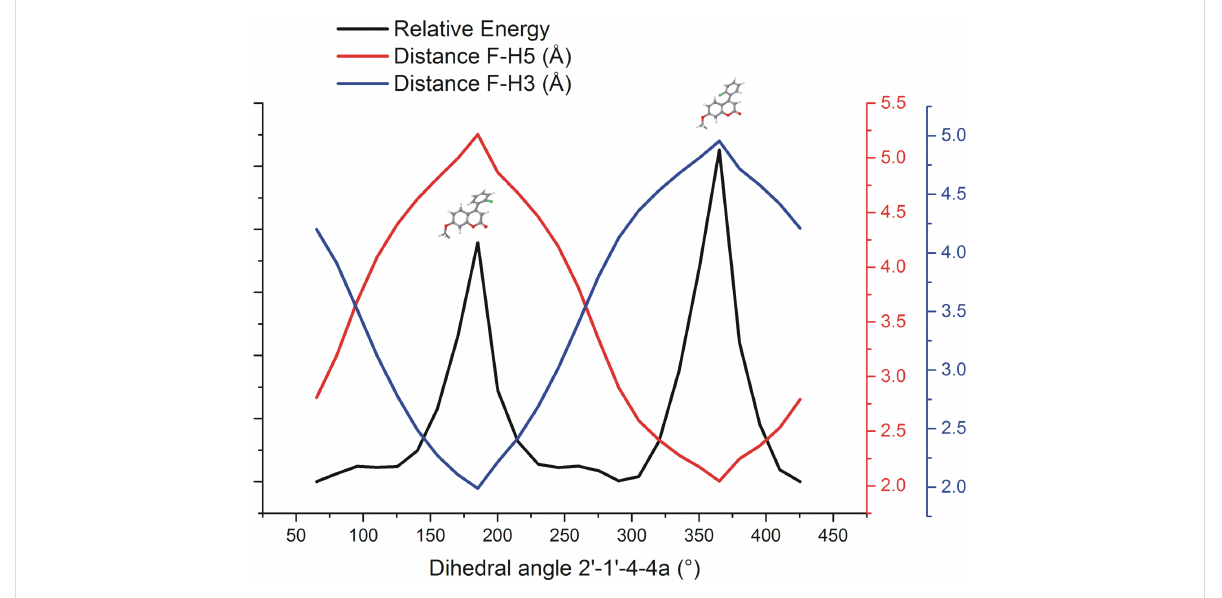
Figure 6: Plots of relative energy (black trace, no units), interatomic distance F–H5 (red trace, Å), interatomic distance F–H3 (blue trace, Å) as a func- tion of dihedral angle Φ C2’–C1’–C4–C4a (°).